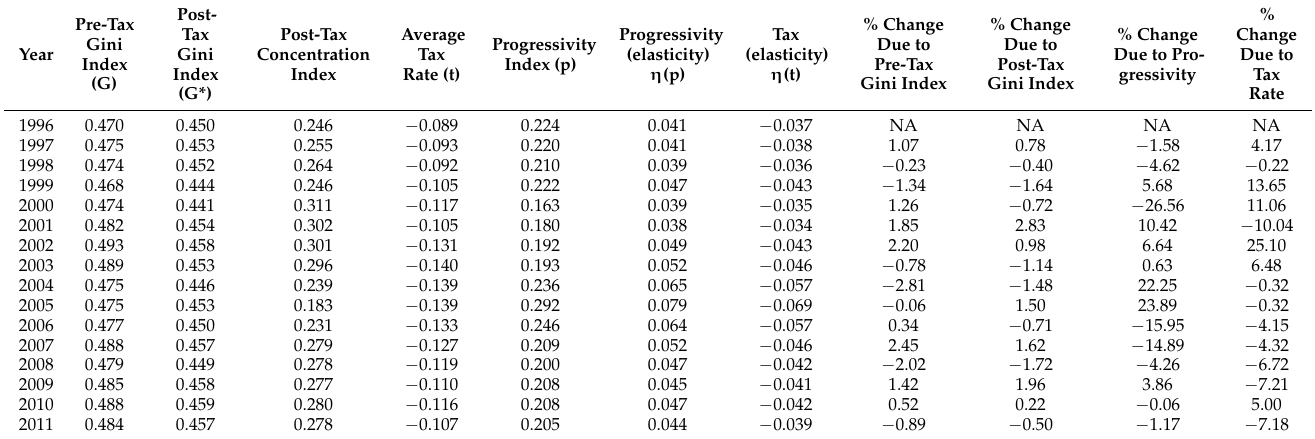
Table 4. Tax progressivity for white CPS respondents for years 1996 to